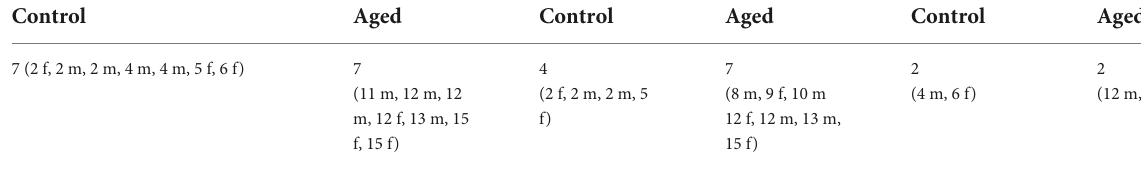
Figure 5 RBPMS density Figure 6 RBPMS fovea Figure 7 Iba1 microglia